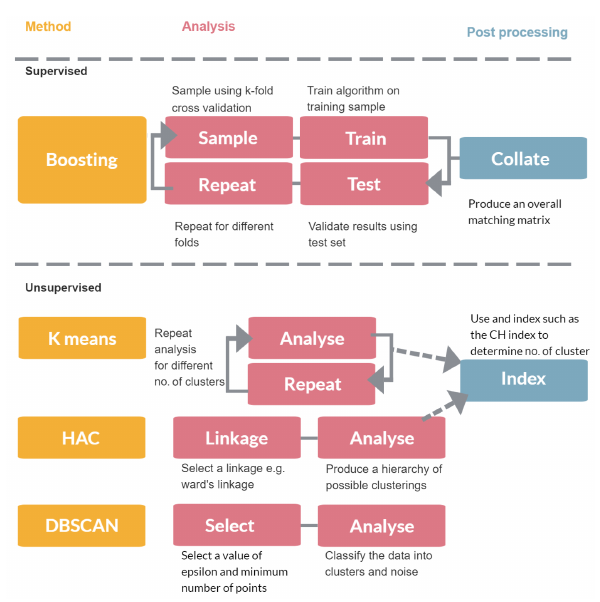
Figure 1. Overview of different analysis approaches.